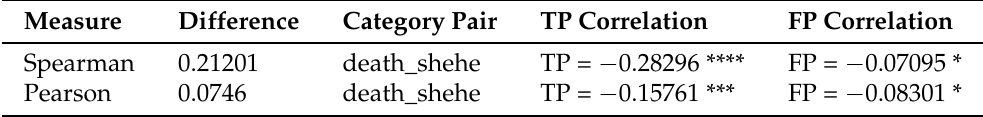
Table 26. Death and 3rd person singular in